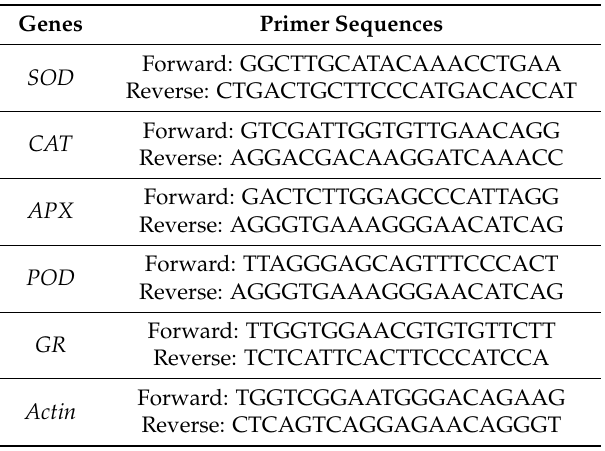
Table 3. Primer sequences of the selected antioxidant enzyme genes.